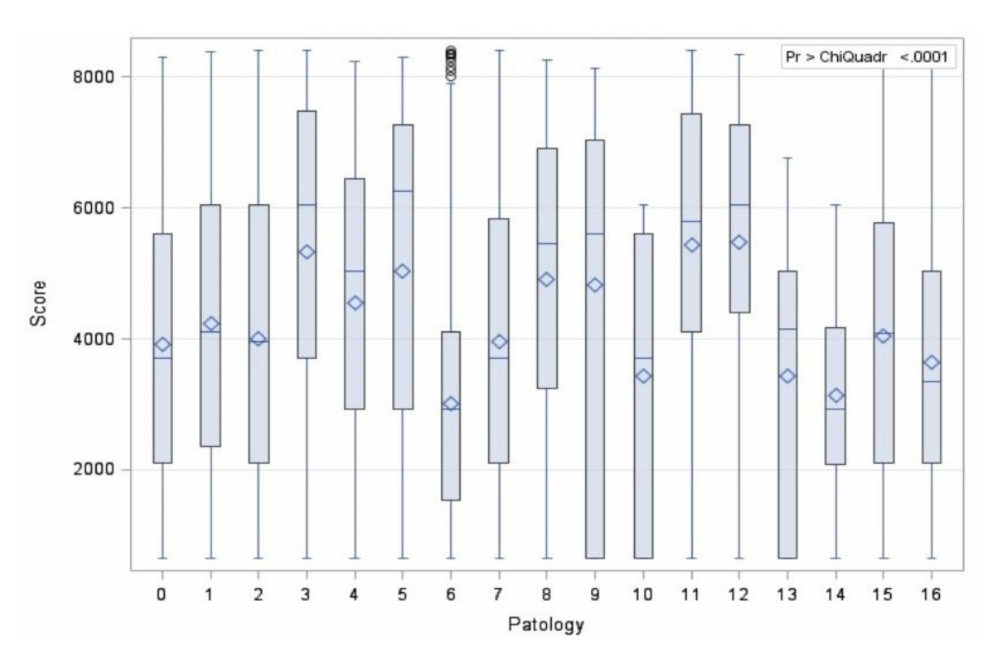
Figure 1. Correlation between SUVmax and histological types.